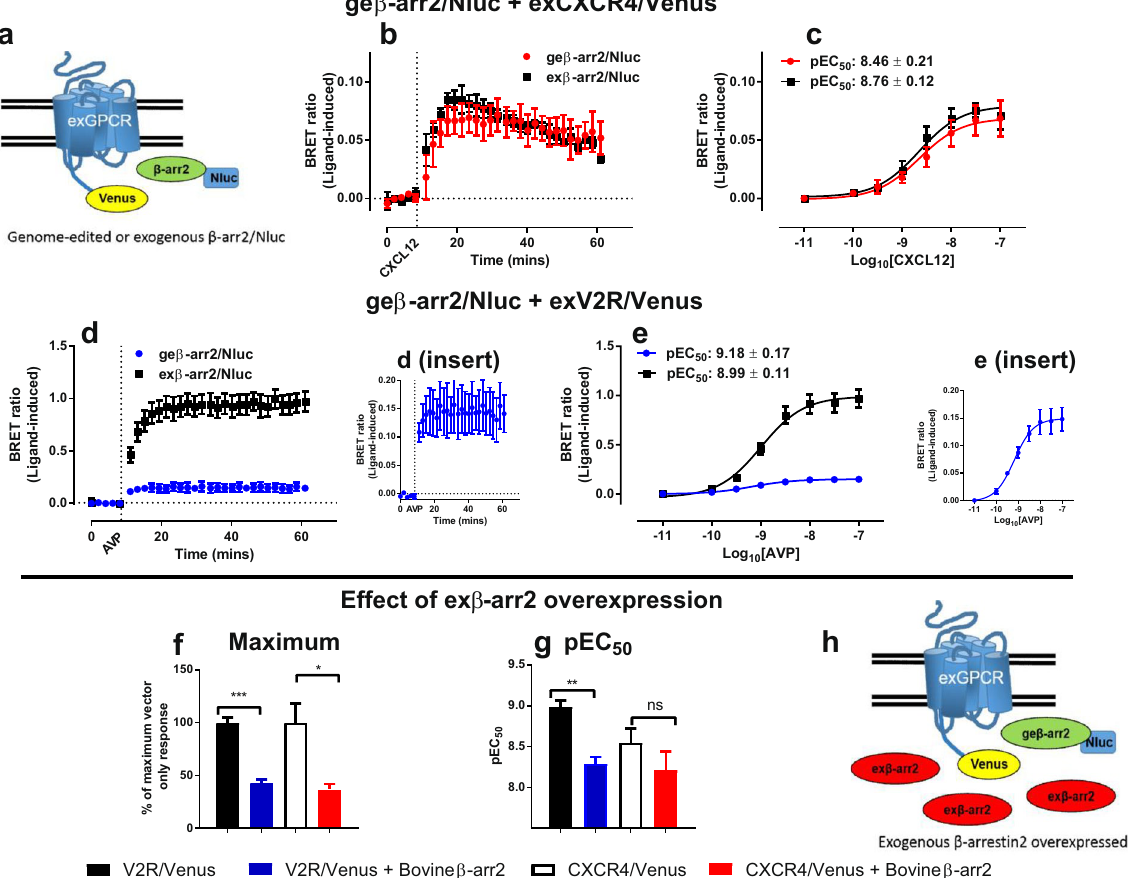
Figure 2. Investigating recruitment of genome-edited β -arrestin2 using BRET. ( a ) Schematic representation of the exogenously expressed GPCR fused to Venus (exGPCR/Venus) and β -arr2/Nluc BRET configuration. HEK293FT cells expressing genome-edited β -arrestin2 fused to Nluc (ge β -arr2/Nluc) transiently transfected with cDNA coding for ( b , c ) CXCR4 fused to Venus (exCXCR4/Venus; red circles) or ( d , e ) V2R fused to Venus (exV2R/Venus, blue circles) as well as HEK293FT cells transiently co-transfected to express exogenous β -arrestin2 fused to Nluc (ex β -arr2/Nluc, black squares) at near endogenous levels and ( b , c ) exCXCR4/ Venus or ( d , e ) exV2R/Venus. ( b , d ) Kinetic profiles of β -arrestin2/Nluc recruitment initiated by addition of CXCL12 (30 nM) or AVP (100 nM) for CXCR4 and V2R respectively. Concentration-dependent recruitment of genome-edited or exogenous β -arrestin2/Nluc to ( c ) exCXCR4/Venus or ( e ) exV2R/Venus mediated by CXCL12 (10 pM–100 nM) or AVP (10 pM–100 nM) respectively. Inserts show ge β -arr2/Nluc recruitment to exV2R/Venus presented in ( d , e ). ( f , g ) Effect of overexpression of unlabelled exogenous β -arrestin2 (blue and red bars) on maximum recruitment response ( f ) and potency ( g ) in HEK293FT cells expressing ge β -arr2/Nluc transiently transfected with cDNA encoding exCXCR4/Venus (white and red bars) or exV2R/Venus (black and blue bars). ( h ) Schematic representation of the BRET configuration used in ( f , g ). ‘BRET ratio (ligand-induced)’ was calculated as described in Methods . Points and bars represent mean ± S.E.M. of three or four independent experiments. Statistical analysis by unpaired two-tailed t-test: ns, not significant, t-value = 1.144, df = 6; * p < 0.05, t-value = 3.610, df = 6; ** p < 0.01, t-value = 6.105 df = 4; *** p < 0.001, t-value = 9.817 df =